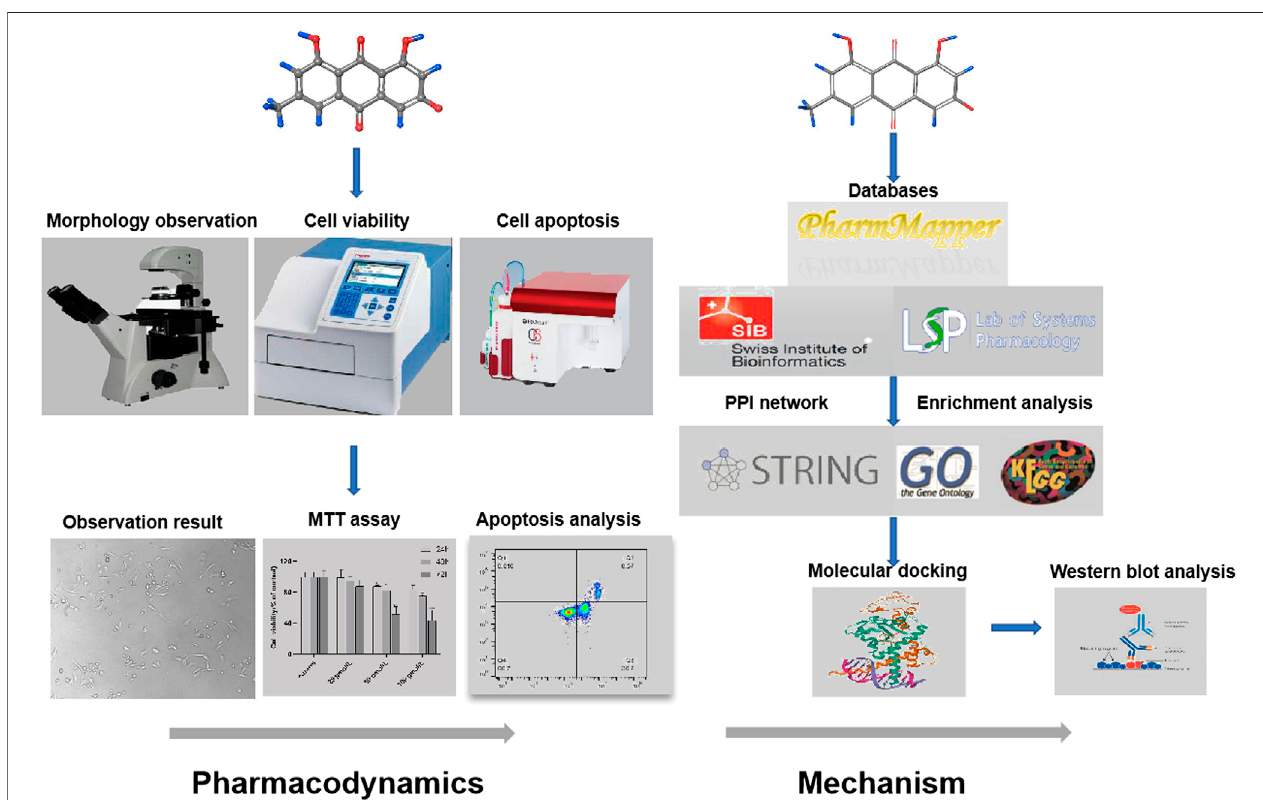
FIGURE 1 | The research fl